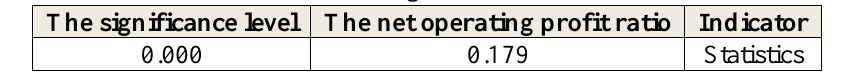
Table 2. Kolmogorov-Smirnov